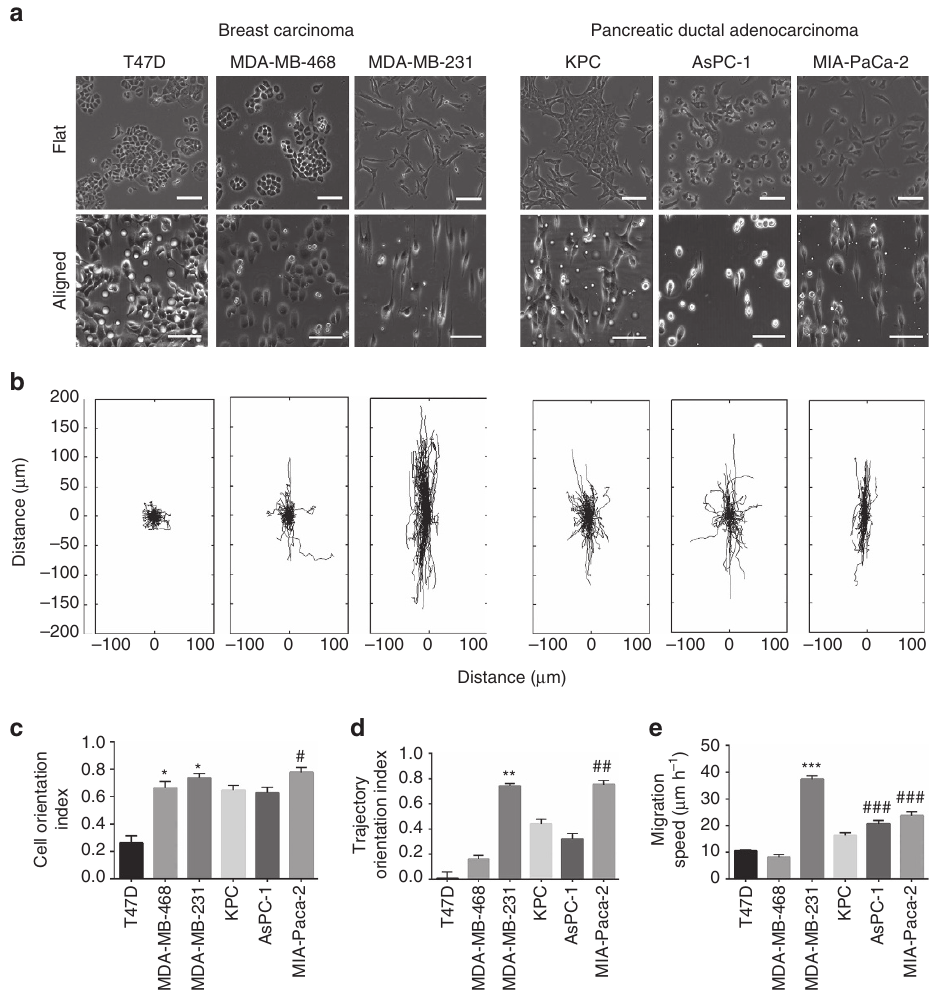
Figure 6 | Phenotypically diverse carcinoma cells respond differently to nanoscale contact guidance cues. ( a ) Morphology of breast and pancreatic carcinoma cell lines on flat (Top) substrates showing the baseline epithelial phenotypes of T47D, MDA-MB-468, KPC, and AsPC-1 cells in contrast to the strong EMT phenotype of MDA-MB-231 and MIA-PaCa-2 cells. (Bottom) On aligned substrates, cells respond readily by aligning along the contact guidance cues. Scale bar, 50 m m. ( b ) Cell trajectory plots mapping migration path over time on aligned ECM demonstrate responsiveness to contact guidance and the cell line specific heterogeneity of the response. ( c , d ) Cell ( c ) and Trajectory ( d ) orientation indices demonstrating responsiveness to contact guidance for all cell lines and a more robust response in cells with an EMT phenotype (for c : n ¼ 70–120 cells per group; * P o 0.0001 for T47D versus MDA-MB-468 and MDA-MB-231 cells; # P o 0.001 for KPC and AsPC-1 versus MIA-PaCa-2 cells; for d : n ¼ 90–220 cells per group; ** P o 0.0001 for T47D and MDA-MB-468 versus MDA-MB-231 cells; ## P o 0.0001 for KPC versus AsPC-1 and MIA-PaCa-2 cells). ( e ) Migration speed of each cell line on aligned topography determined from the PRWM showing the highest speed in cells with an EMTphenotype ( n ¼ 50–100 cell per group; *** P o 0.0001 for T47D and MDA-MB-468 versus MDA-MB-231; ### P o 0.0001 for KPC versus AsPC-1 and MIA-PaCa-2 cells). Data in c – e are mean ± s.e.m., all comparisons by the Kruskal–Wallis test.